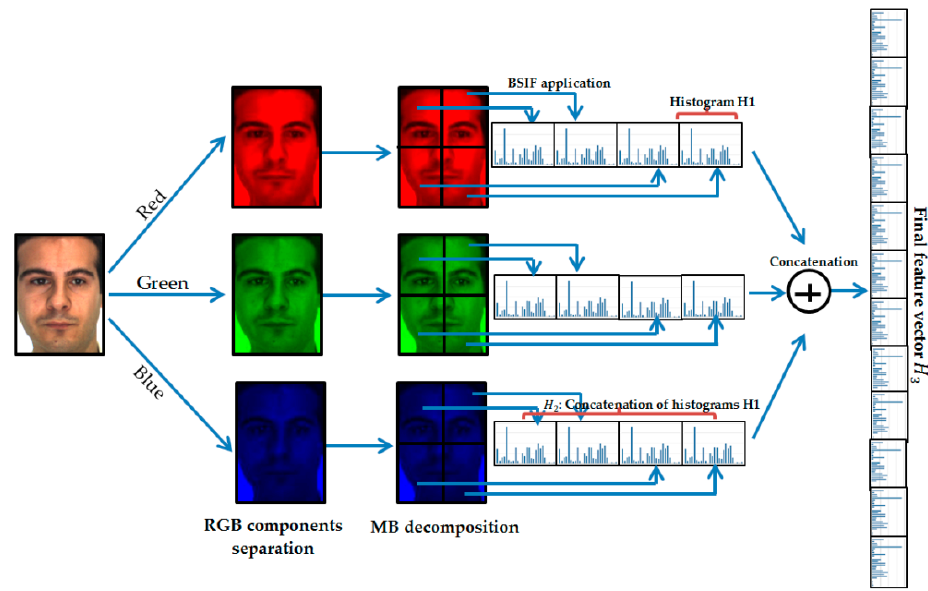
Figure 5. Structure of the proposed feature extraction approach: